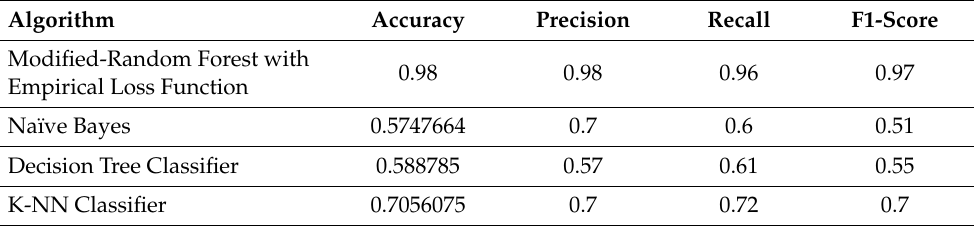
Table 8. Analysis of M-RF classifier with other ML classifiers (NB, K-NN, and DT).